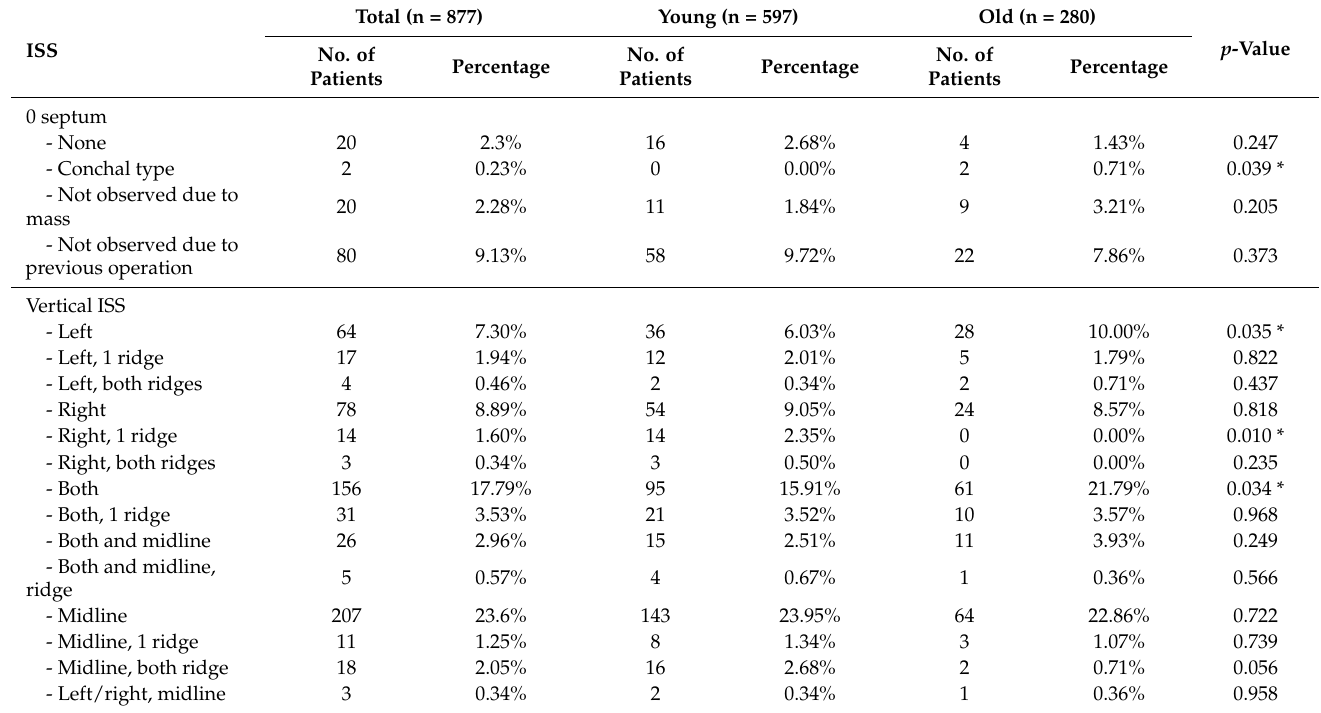
Table 3. Classification of intersphenoid sinus septation morphology based on the inoperative